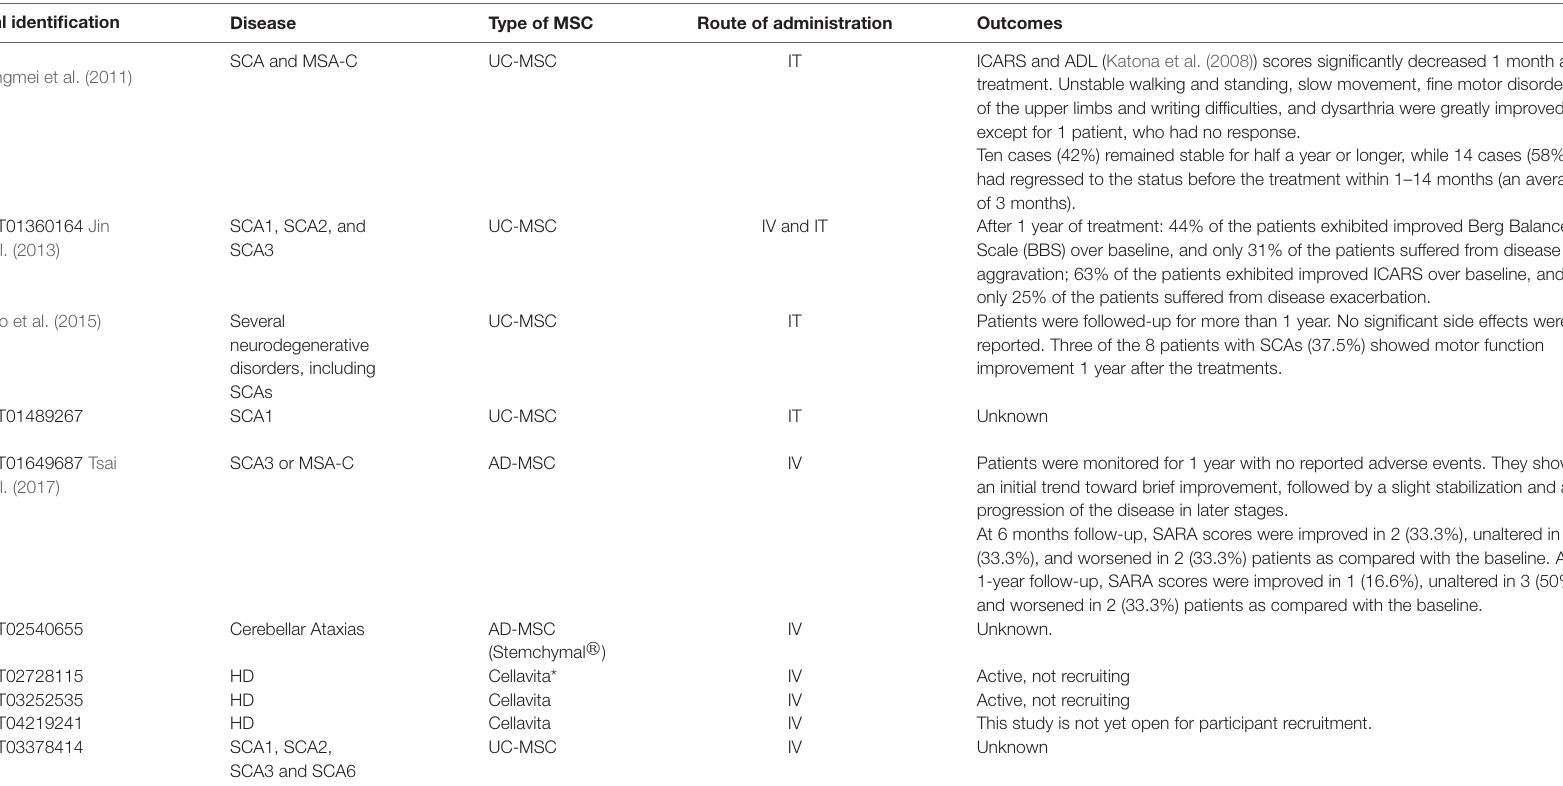
TABLE 2 | Concise information on the outcomes obtained from clinical trials performed with MSCs in patients with PolyQ